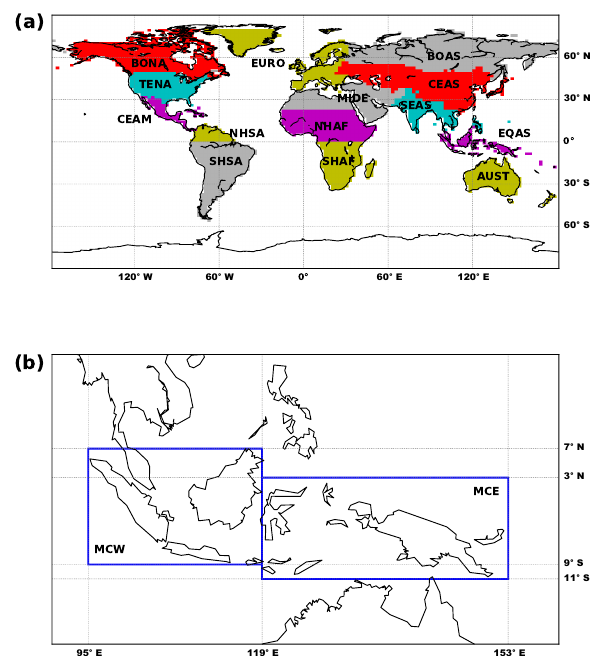
Figure 1. (a) The GFED4.0s basis regions, regridded to the model resolution of approximately 1.9 ◦ × 2.5 ◦ using nearest- neighbour interpolation: Boreal North America (BONA), Temper- ate North America (TENA), Central America (CEAM), Northern Hemisphere South America (NHSA), Southern Hemisphere South America (SHSA), Southern Hemisphere Africa (SHAF), North- ern Hemisphere Africa (NHAF), the Middle East (MIDE), Europe (EURO), Boreal Asia (BOAS), Central Asia (CEAS), Southeast Asia (SEAS), Australia and New Zealand (AUST), and Equatorial Asia (EQAS). (b) The two regions used instead of EQAS in this study: the Western Maritime Continent (MCW), and the Eastern Maritime Continent (MCE). Unlike the land-only GFED4.0s basis regions, the two maritime continent regions both include ocean as well as land, due to the difficulty of distinguishing land from ocean at a resolution of 1.9 ◦ × 2.5 ◦ over the maritime continent. In the other figures and tables, Northern Hemisphere is often abbreviated to NH, while Southern Hemisphere is abbreviated to